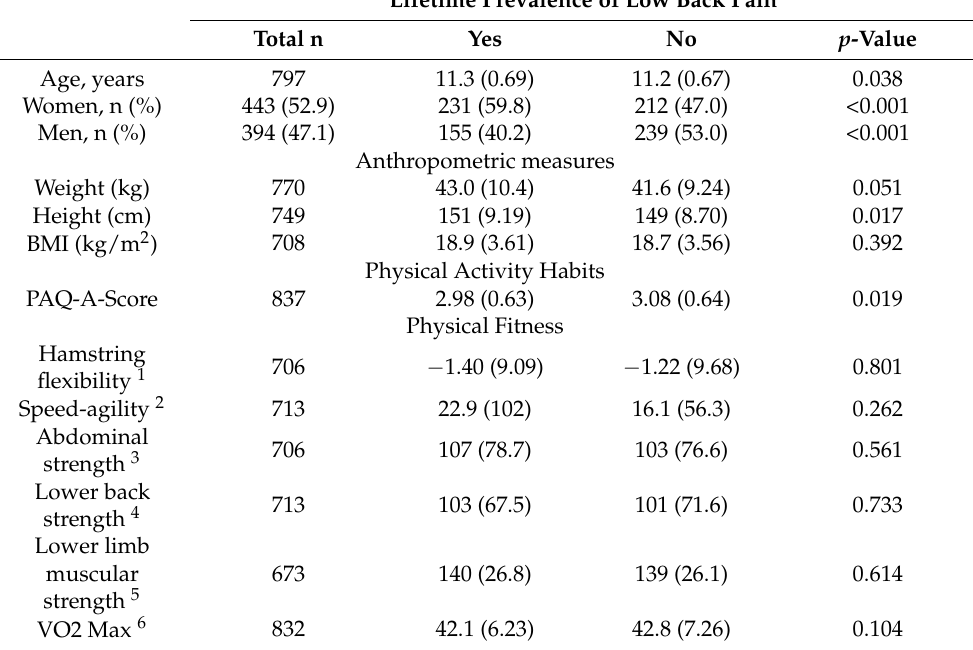
Table 1. Study population’s baseline characteristics across categories of frequency of lifetime preva- lence of low back